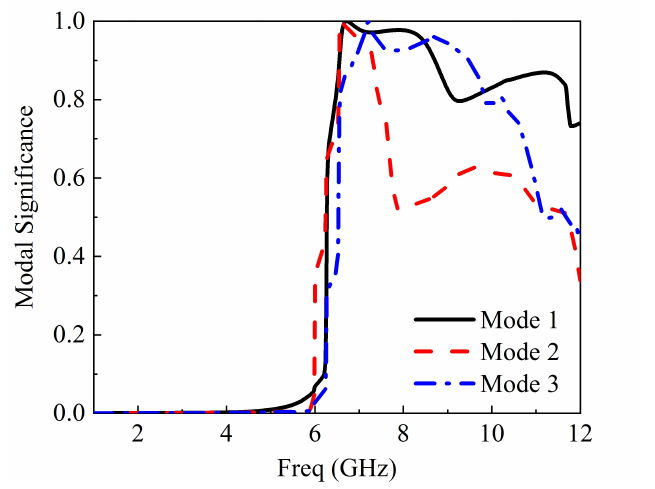
Figure 15. Modal significance at 7 GHz.